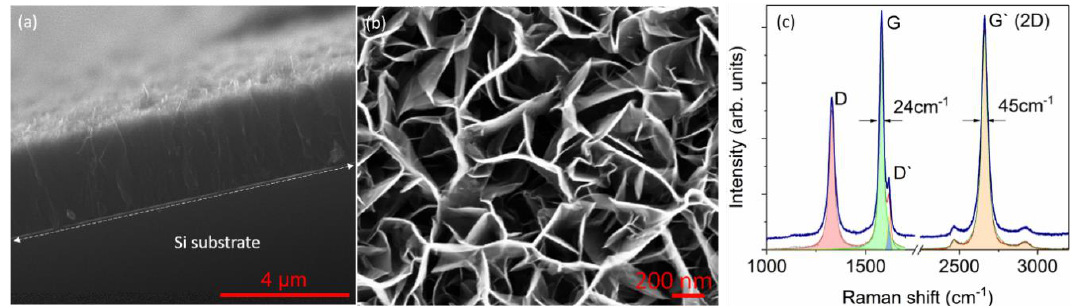
Figure 2. ( a , b ) Scanning electron microscopy (SEM) images of the graphene sample, showing intercalated graphene flakes, entangled in a vertical direction, perpendicular to the sample surface. ( c ) Raman spectra of the vertically aligned graphenes (VAGs) showing sharp G and 2D peaks, including a low-intensity D peak.